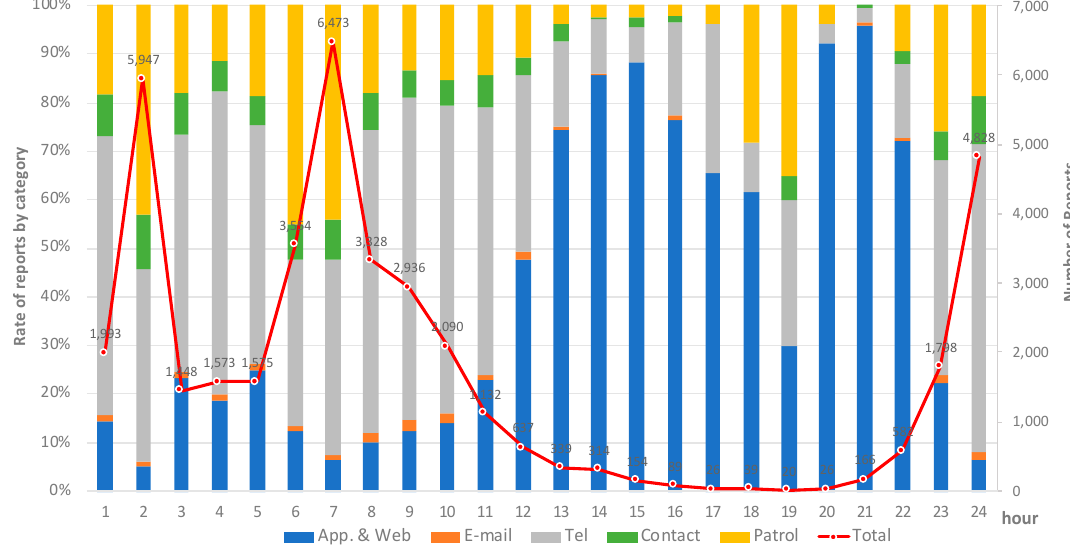
Figure 8. Hourly distribution of Chiba-repo reports.